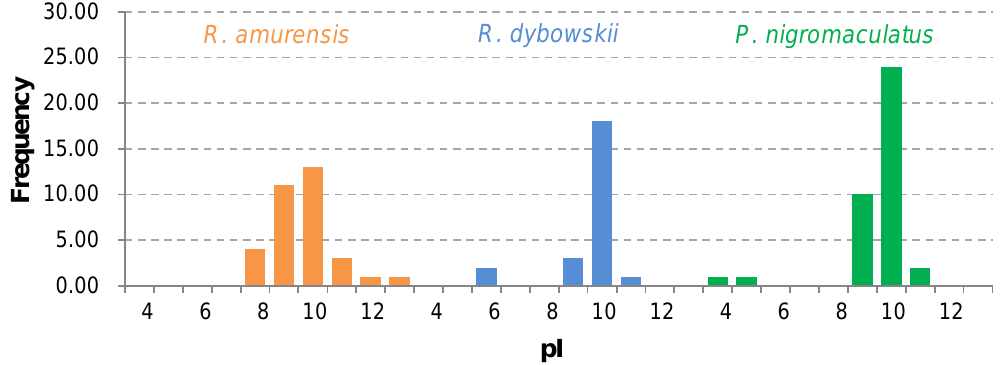
Figure 7. Frequency distribution of theoretical isoelectric points (pI) of antimicrobial peptides (AMPs) isolated from the three anuran species.